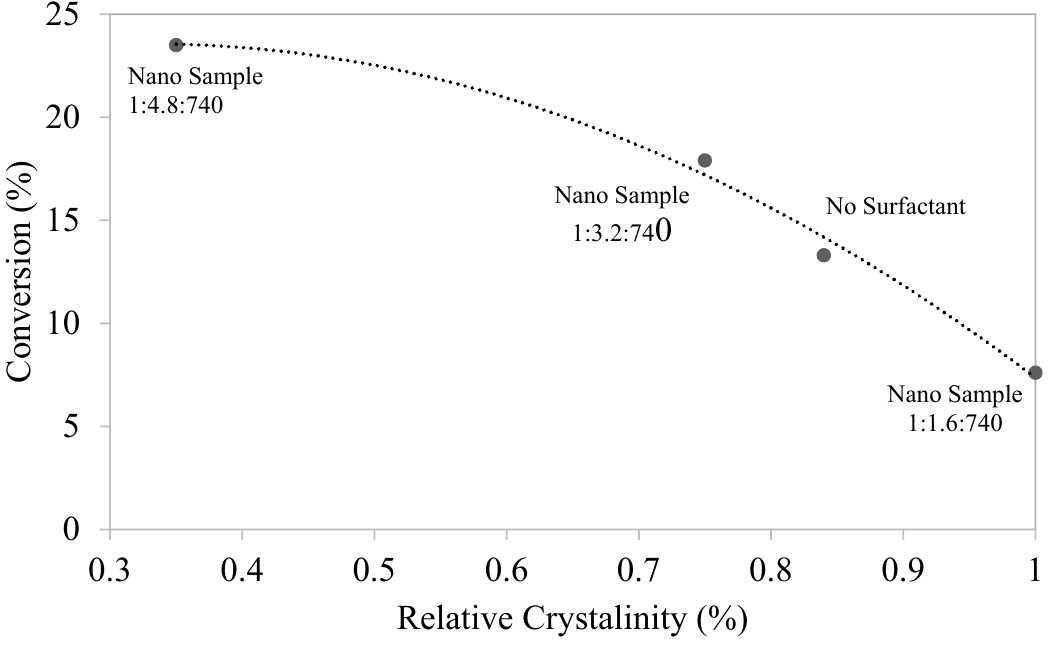
Figure 8. Relative crystallinity (%) vs. conversion (%).